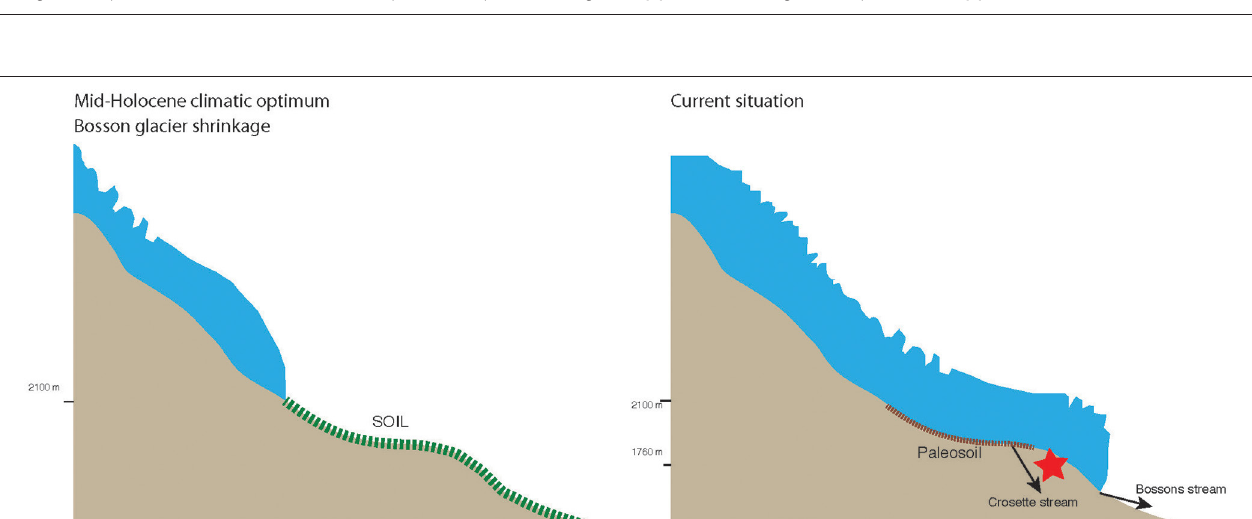
Frontiers in Earth Science | www.frontiersin.org